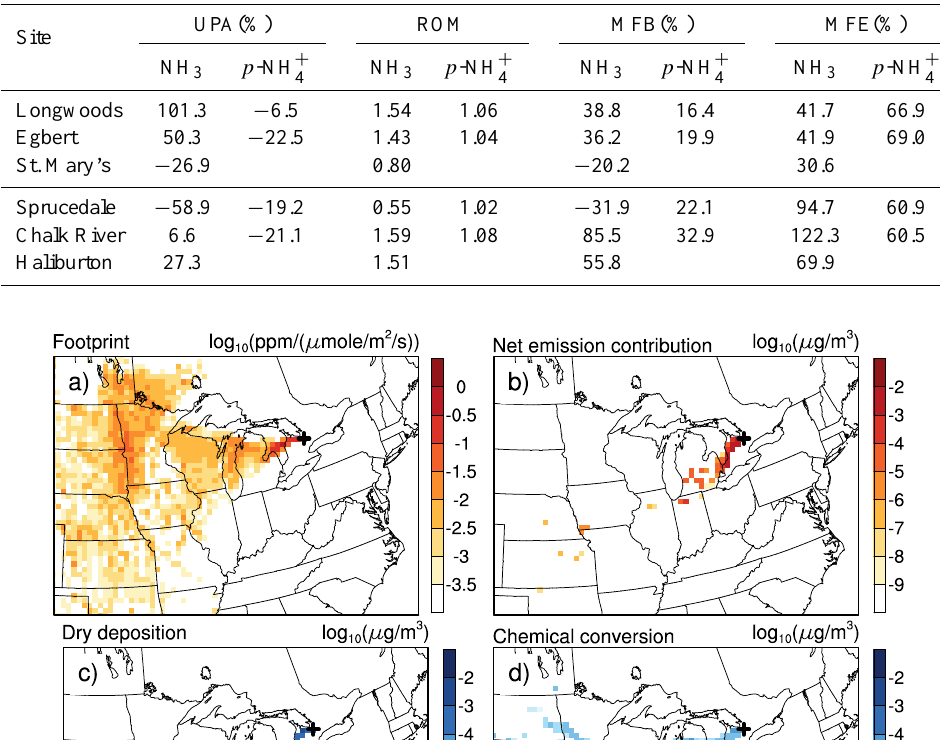
concentrations. 4